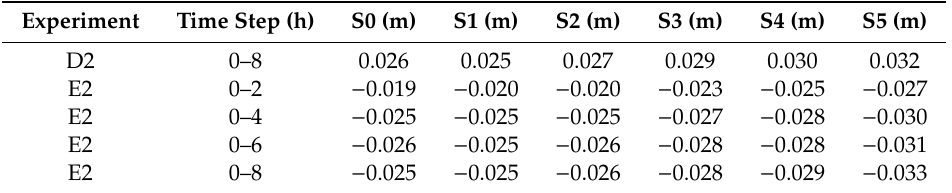
Table 5. Mean elevation change for 1-m long sections along the flow path for the test runs D2 and E2. Experiment Time Step